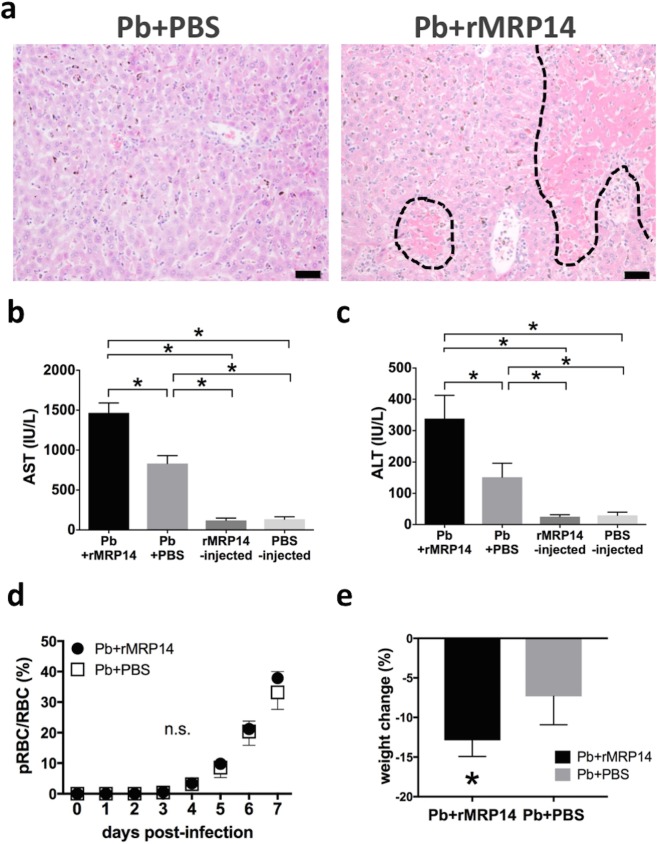
Exacerbation of hepatic injury by rMRP14 during rodent malaria.(a) Histopathology of the liver of mice injected with rMRP14 or PBS after Pb-infection analyzed by HE staining. The area surrounded by dotted line shows focal necrosis. Bar; 50 µm. (b)(c) Serum concentration of AST (b) and ALT (c) of mice injected with rMRP14 or PBS after Pb-infection (n = 5). (d) No effect of rMRP14 on parasite proliferation. Kinetics of pRBC rate in peripheral blood after infection of 106 pRBCs in rMRP14-injected mice and PBS-injected controls (n = 5). (e) The body weight change of mice injected with rMRP14 or PBS after Pb-infection (n = 5). Graphs show mean and SD of each group. Data are representative of two independent experiments. *P < 0.05; n.s., not significant.